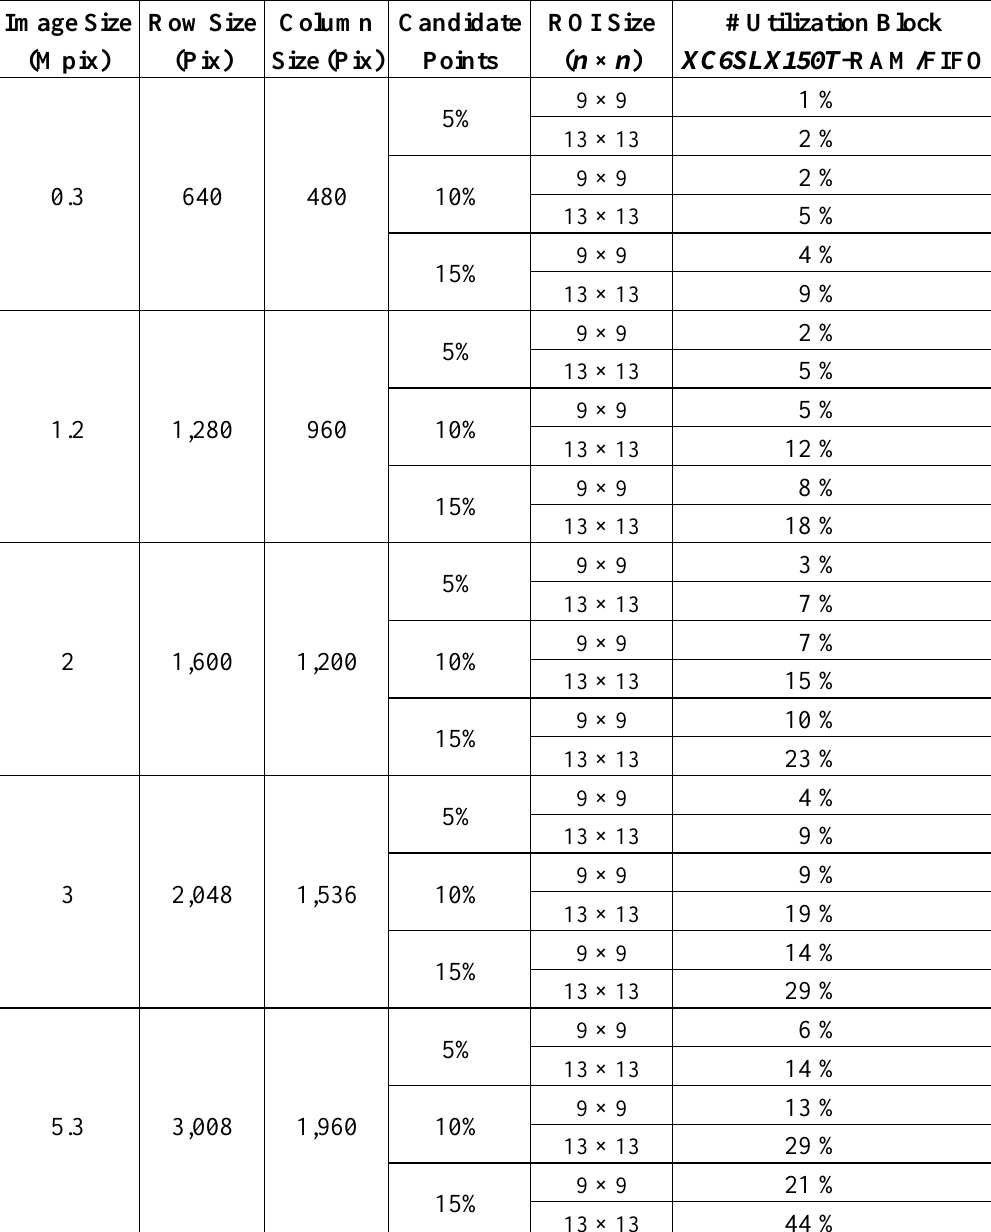
Table 3. Resources used on a XC6SLX150T: Block